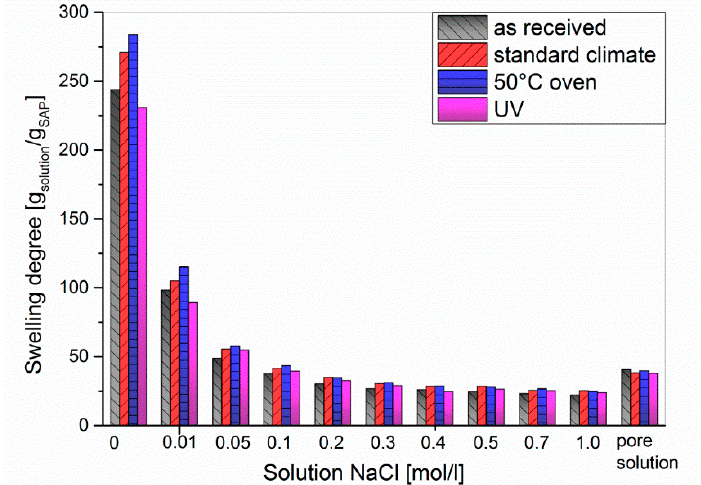
Figure 7. Swelling degree of SAP 1 in sodium chloride solutions.